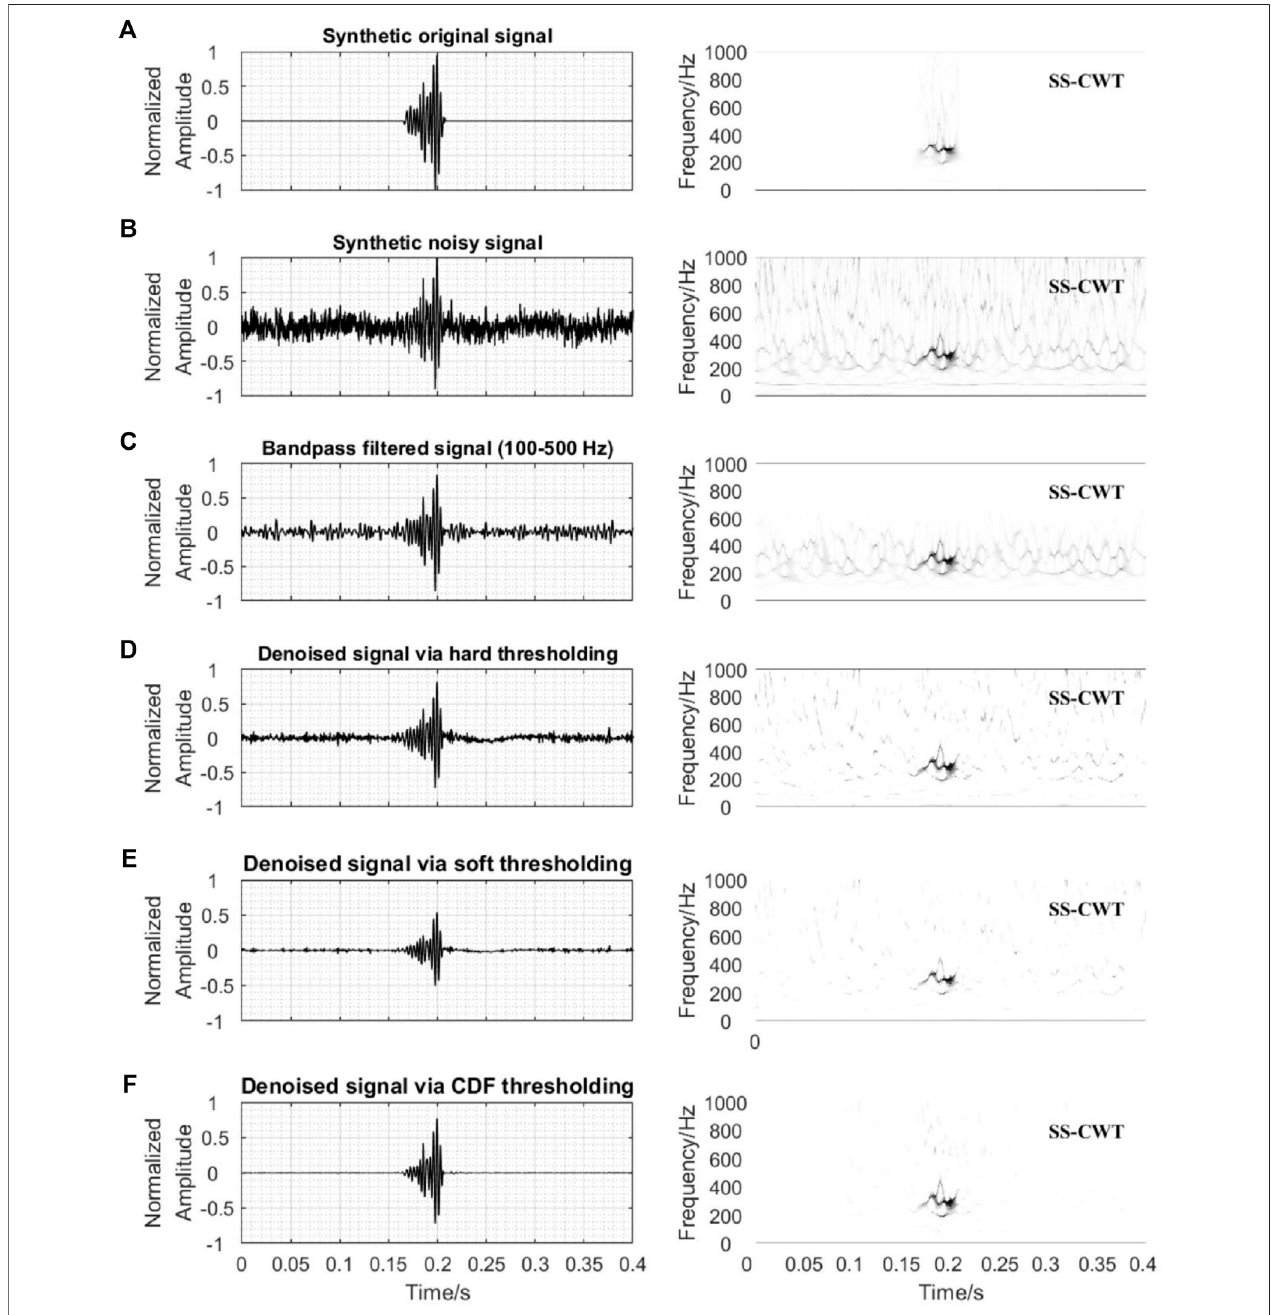
thresholding produces smaller errors but often results in oversmoothing of the denoised signal. In the next step, we add a post-processing step to smooth residual noise and minimize damage to the amplitude of the microseismic signal as much as